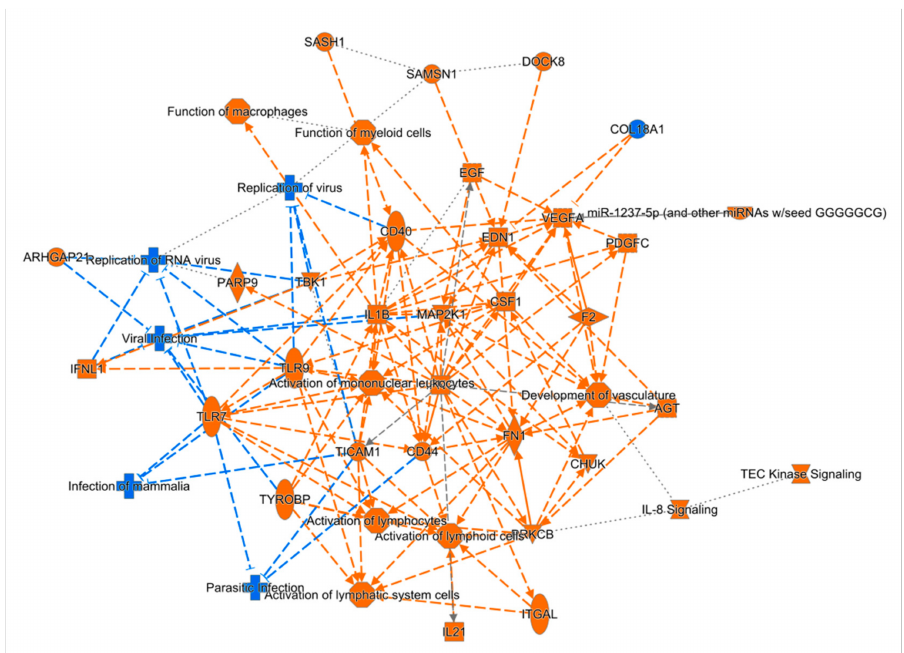
Figure 4. Graphical summary of the pathway analysis of differentially expressed genes in the ipsilateral thalamus after traumatic brain injury. Similar to the perilesional cortex, analysis highlighted physiologic functions, such as organismal survival, tissue morphology, nervous system development and function, and hematologic system development and function. Top regulator effect networks included genes such as Collagen Type XVIII Alpha 1 Chain (COL18A1) and SELPG